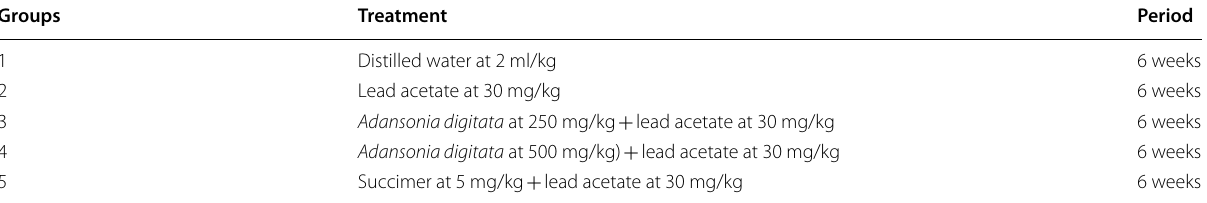
Table 1 Summary of experimental design Groups